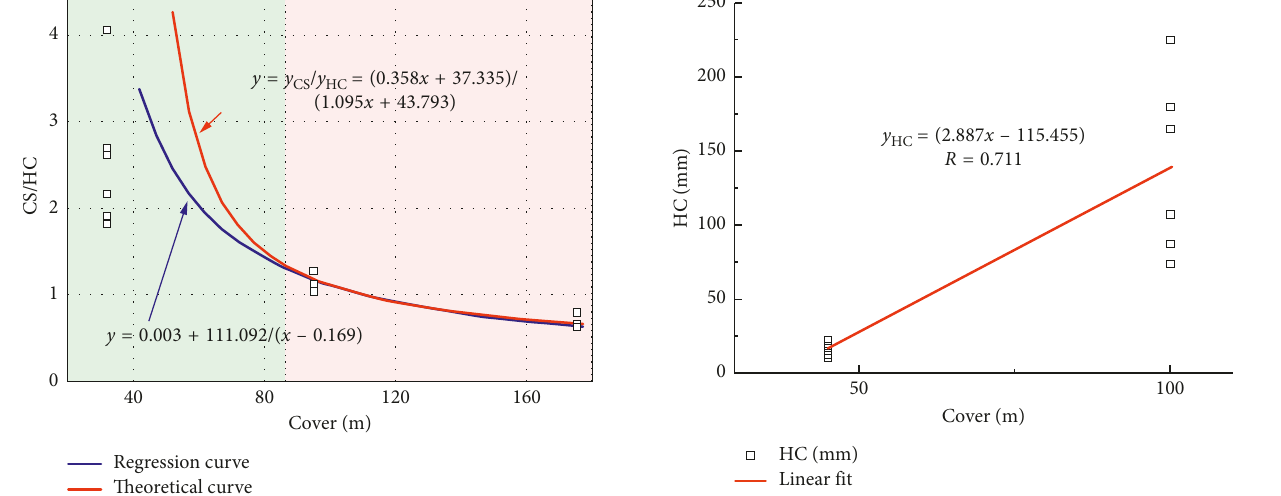
Figure 9: Comparison between theoretical curve and regression curve on relation of CS/HC with cover depth at 15.2 span. The graph of equation (3) was regarded as the theoretical curve, and the graph of equation (4) was regarded as the regression curve.